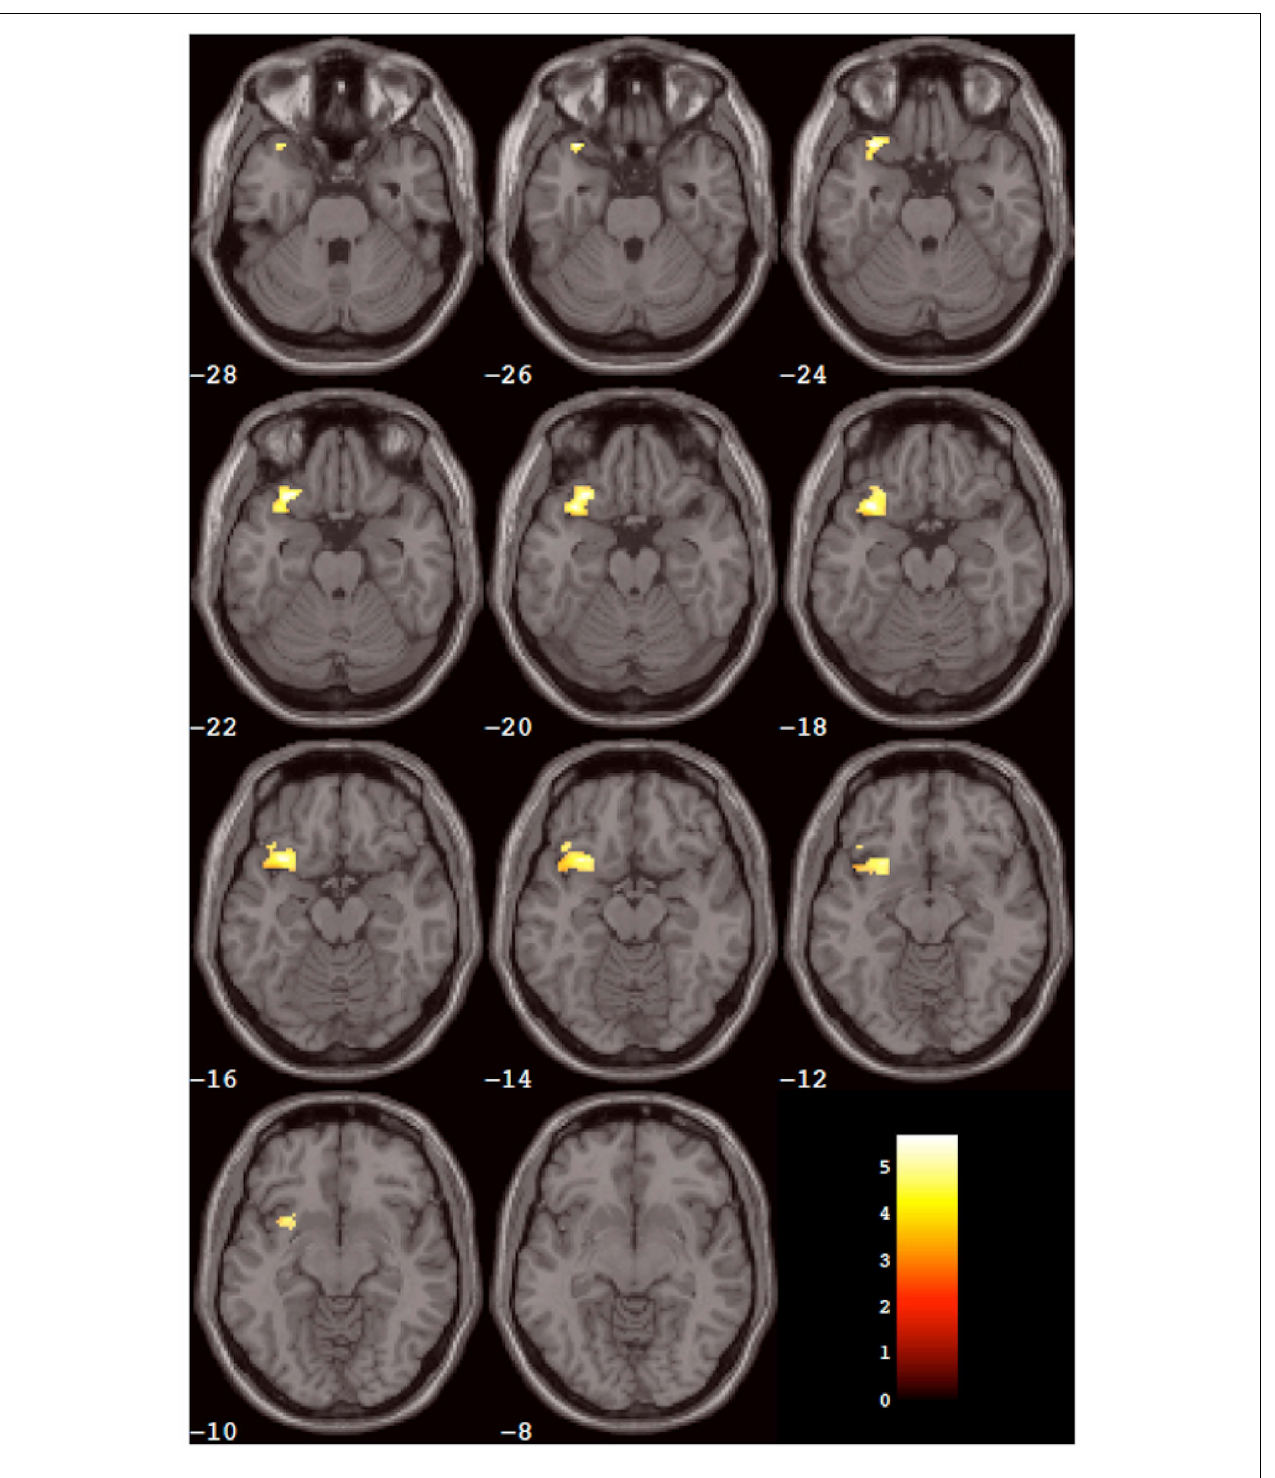
superior slices in the right lower corner of the window.The number in white below each slice is the MNI Z coordinate in mm for that slice.The left hemisphere is on the reader’s left-hand side of each slice.The color scale is in the right lower corner of the window and is in units of the t